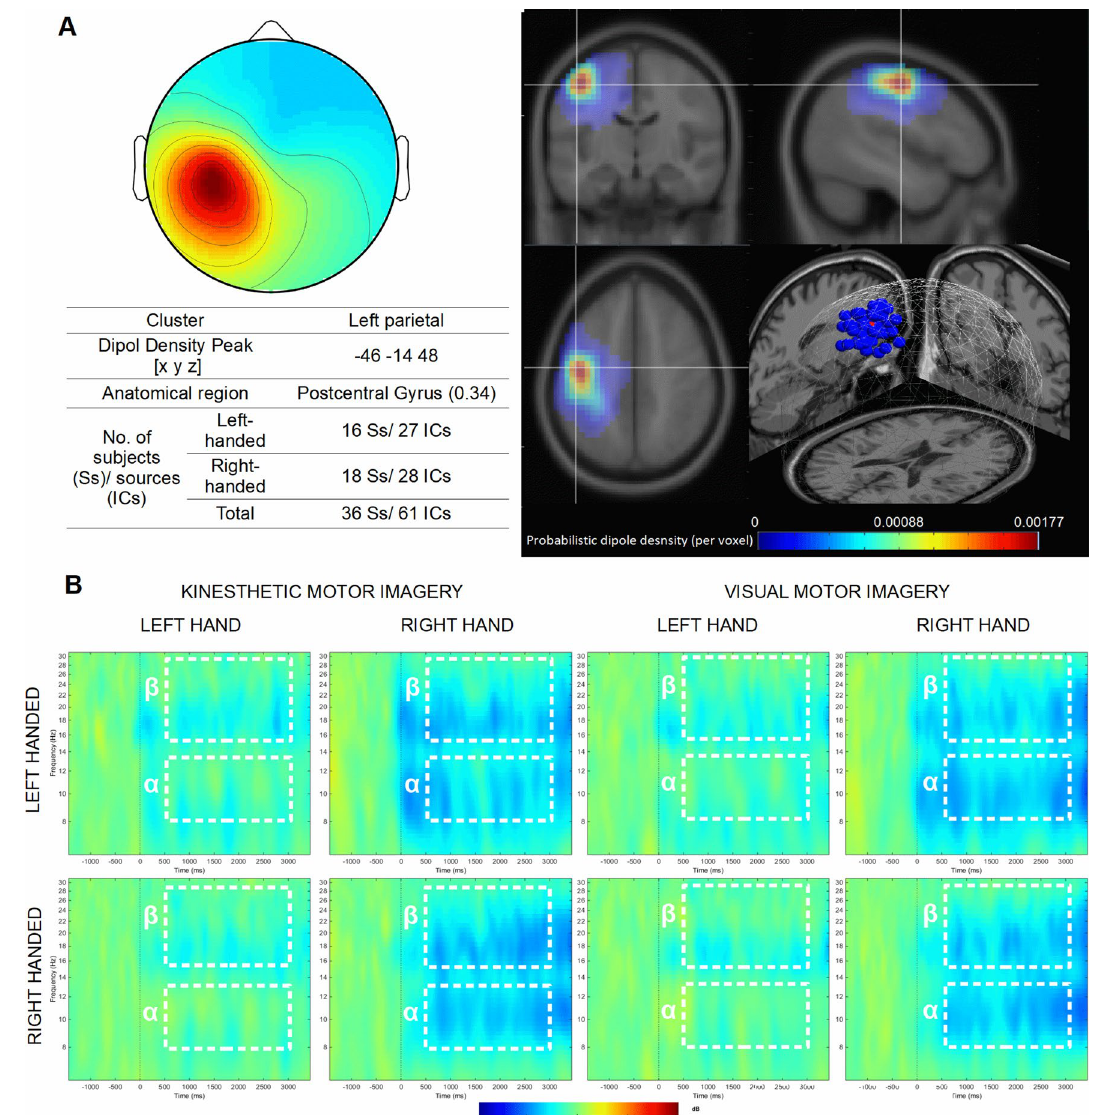
Figure 4. Left parietal cluster. ( A ) Average topography with the estimated anatomical location of the centroid (top left) and visualization of probabilistic dipoles density (top right); ( B ) mean ERSP time × frequency spectrograms from all components for both groups during left- and right hand MI in the KMI and VMI conditions. White dotted lines indicate alpha (α) and beta (β) time–frequency regions averaged for the statistical analysis. Used software to create the images in this figure: MATLAB version R2014b (MathWorks, Natick, MA, USA, https:// www. mathw orks.